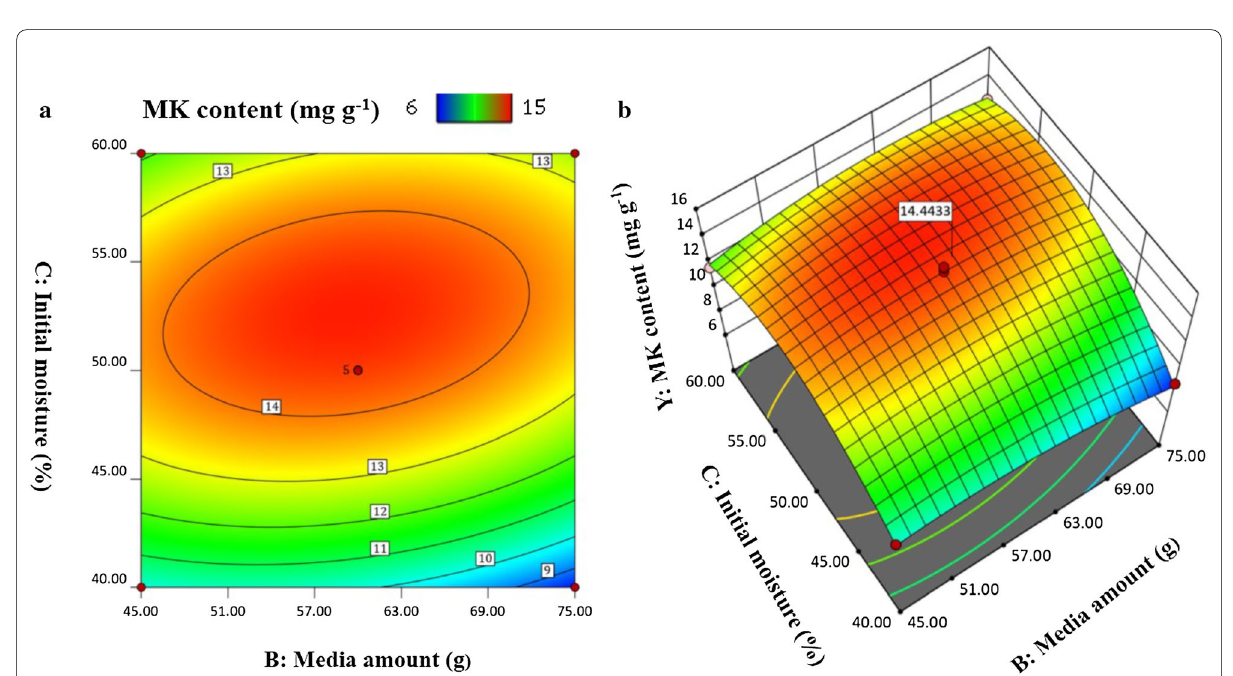
Fig. 6 Interaction between media amount and initial moisture at a fixed bran content of 5%: (a) Contour plot and (b) 3D Surface